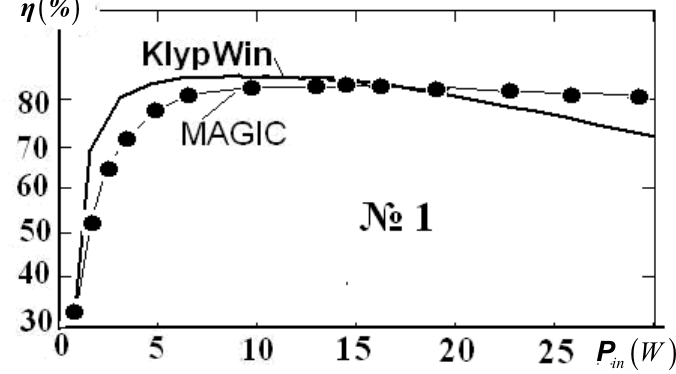
Figure 7. Comparison of the transfer curves of the klystron № 1 Figure 5.